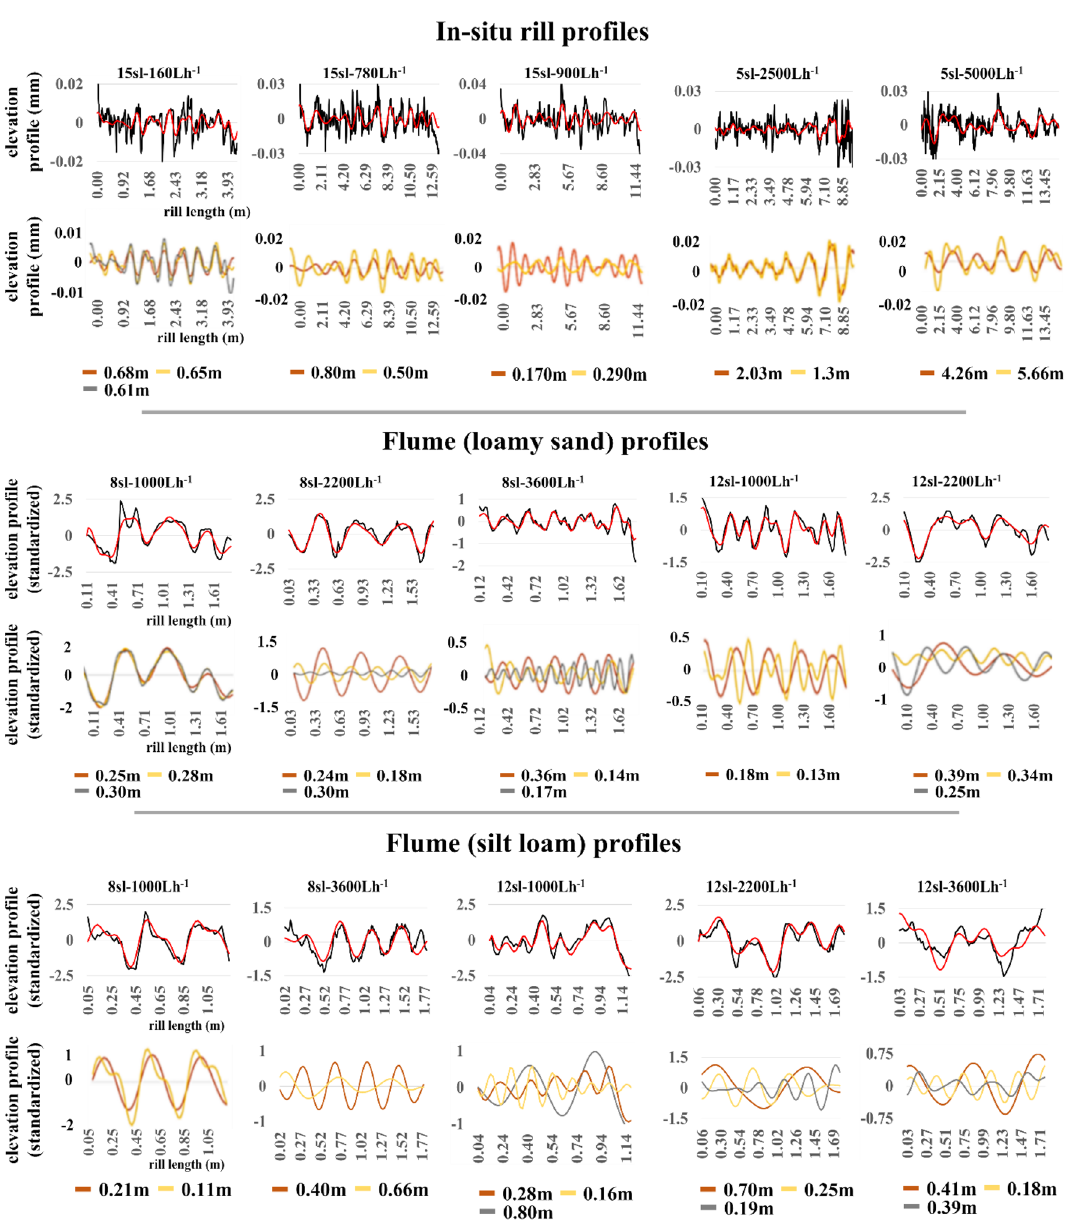
length (m); and lower graphs plot corresponding dominant oscillatory components. Removing the hillside-slope trend component from in-situ rill-bed profiles removes steps from step-pool units in the detrended plots; pools remain in the valleys of the detrended profiles. SSA performed better to isolate high-frequency oscillations in flume rill-bed profiles when standardized by subtracting the profile mean from each observation and dividing by the profile standard deviation. Positive (negative) standardized values represent standard deviations above (below) the mean (the zero value). The plots of signals isolated from in-situ and flume rill-bed profiles fluctuate irregularly without exhibiting clear regularities in the spatial distribution of